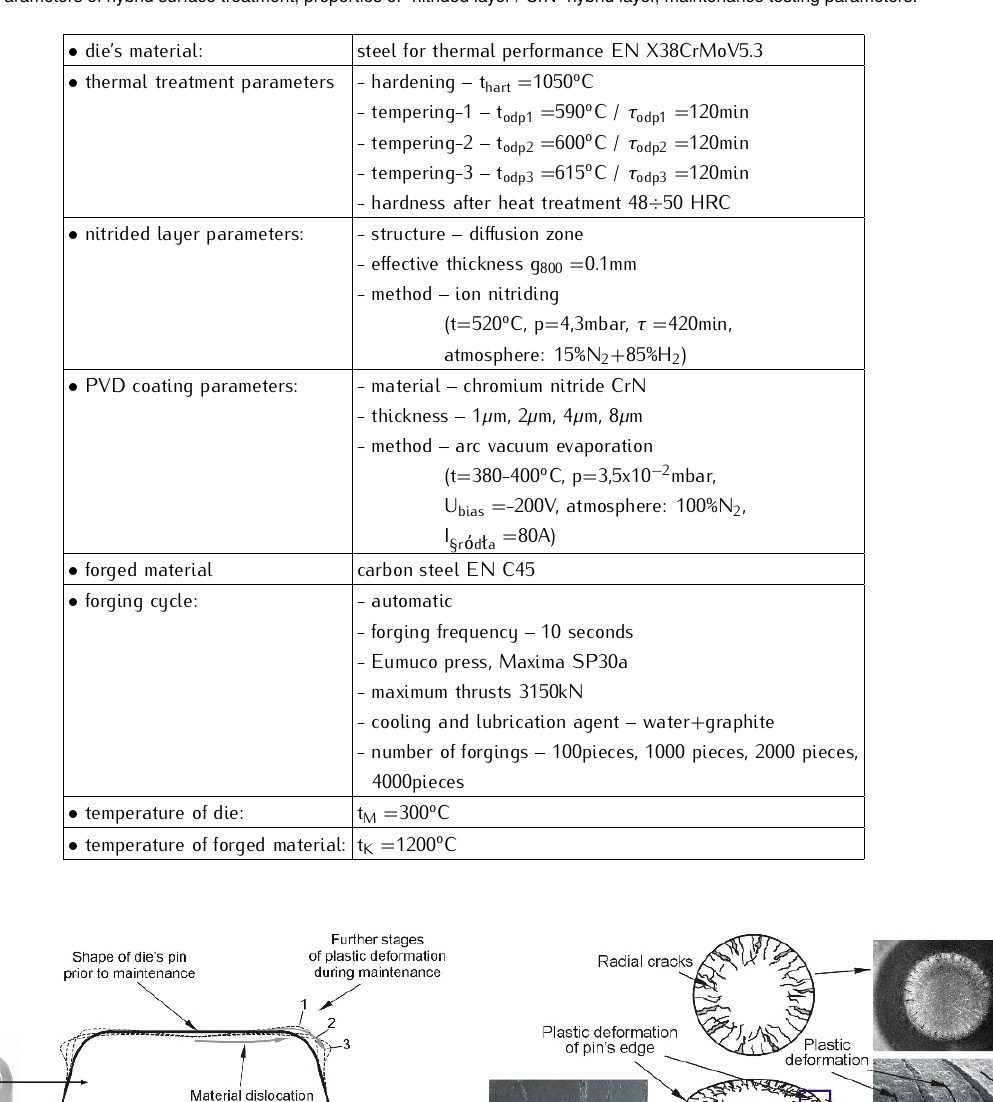
Table 1. Parameters of hybrid surface treatment, properties of “nitrided layer / CrN” hybrid layer, maintenance testing parameters.